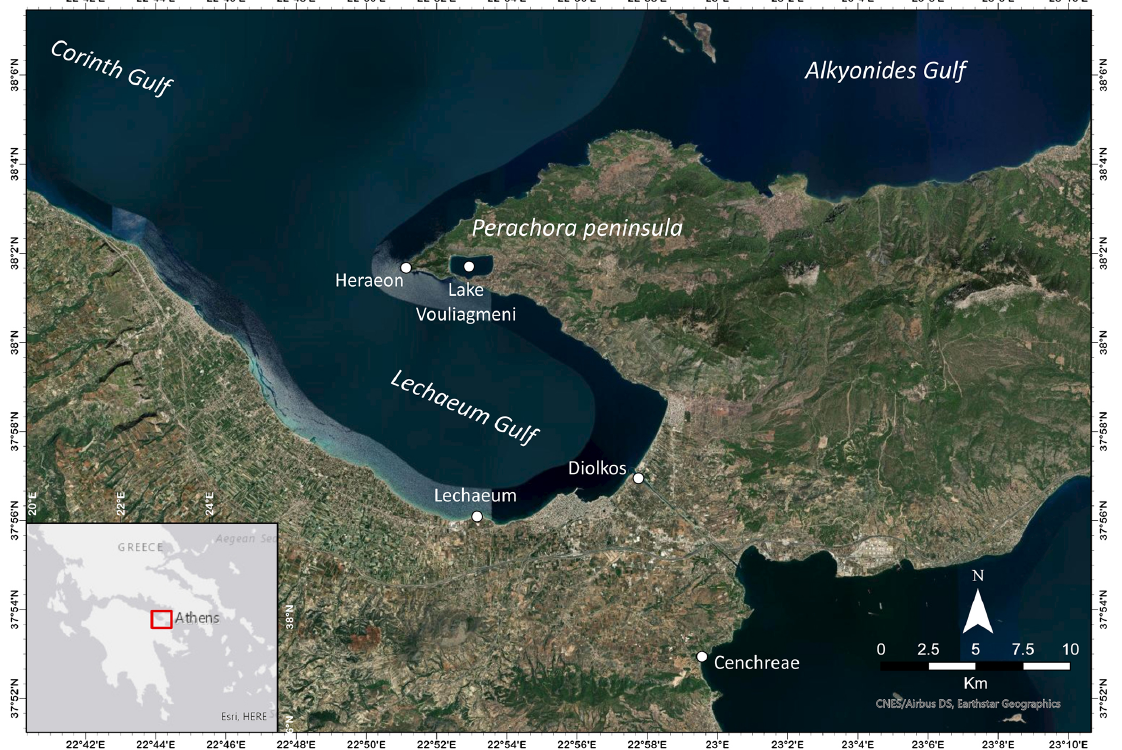
Figure 1. Location of the sites discussed in the text. Inset map shows the location of the study area (red box) (created using ArcGIS